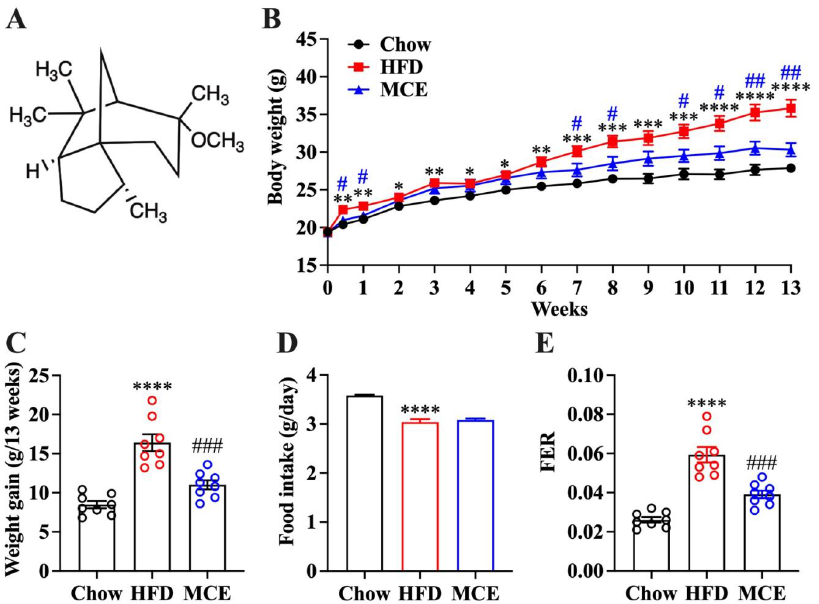
Figure 1. Effects of methyl cedryl ether (MCE) supplementation on high-fat diet (HFD)-induced obesity in mice. ( A ) The chemical structure of MCE. ( B ) Changes in body weight during 13 weeks of feeding. ( C ) Cumulative body weight gain. ( D ) Daily food intake. ( E ) Food efficiency ratio (FER). Data were presented as mean ± SEM ( n = 8). The data for chow and HFD group mice have been reproduced from ref. [11] . * p < 0.05 versus chow group, ** p < 0.01 versus chow group, *** p < 0.001 versus chow group, **** p < 0.0001 versus chow group; # p < 0.05 versus HFD group, ## p < 0.01 versus HFD group, ### p < 0.001 versus HFD group. 3.2. MCE Lowers FBG and Improves Serum Lipid Profile in HFD-Fed Mice The FBG level in MCE-supplemented mice was remarkably lower than that of HFD group mice and was comparable to that of chow diet-fed mice (Table 2). In mice fed with HFD, the effect of MCE on glucose tolerance was minimal (data not shown). Meanwhile, we observed that the serum lipid profile was improved during MCE treatment in HFD- fed mice (Table 2). Table 2. Effects of MCE supplementation on FBG and serum lipid profiles in HFD-fed mice. Chow